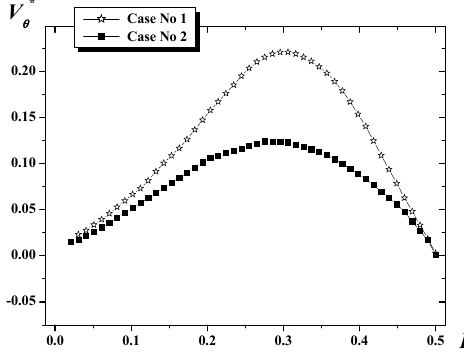
Figure 4. Tangential velocity for Re = 10, Z * = 0.45, θ = 90°.